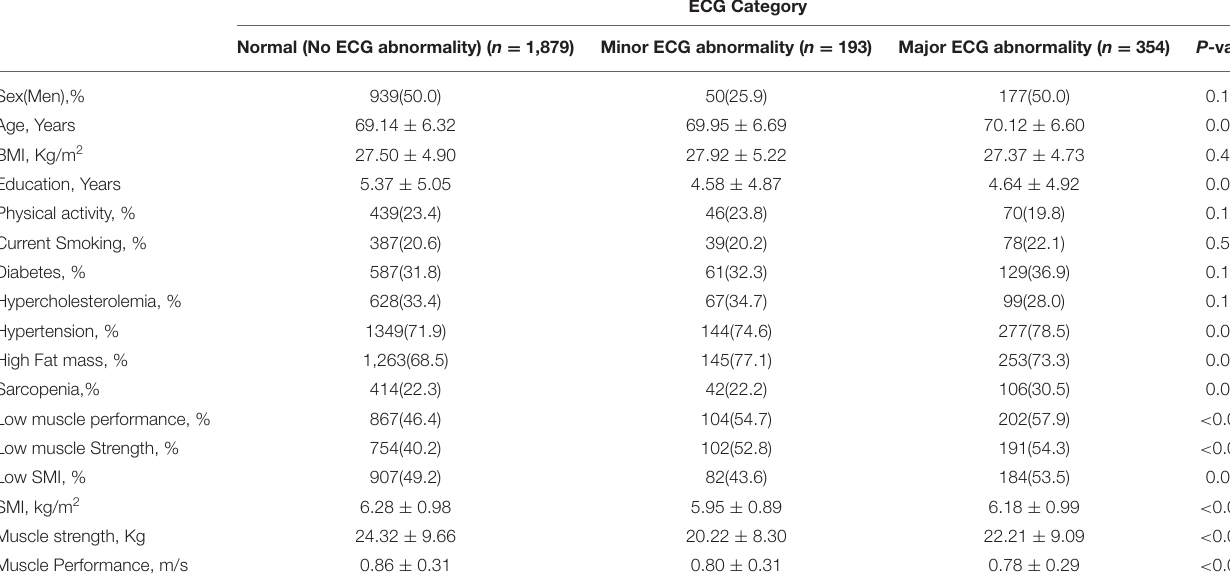
TABLE 1 | General characteristics of the study population according to ECG status.